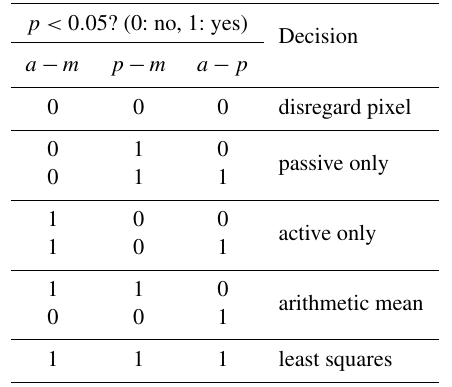
Table 2. Merging scheme based on the one-tailed p value for the correlation between active ( a ), passive ( p ) and modelled ( m ) soil moisture with a 0.05 significance level (modified from Gruber et al.,